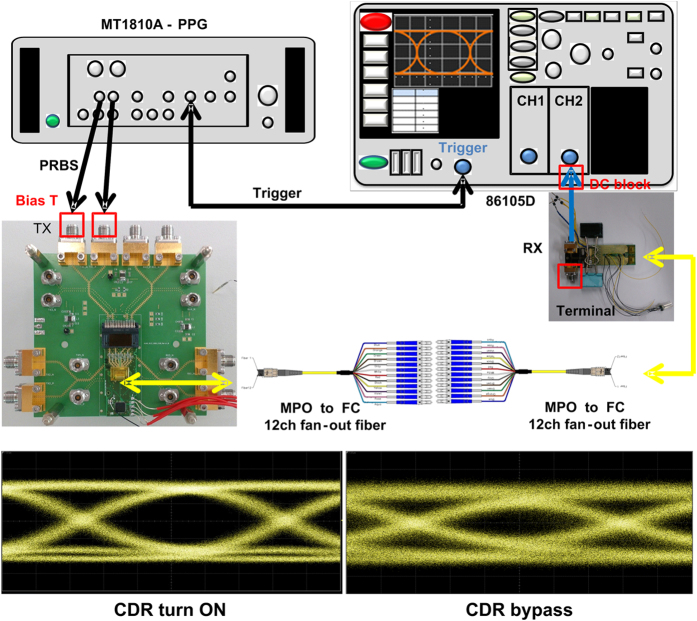
The electrical eye-diagram measurement of the thermoelectrically separated 400-Gbps CDFP receiver.(a) The experimental setup of receiver eye diagram measurement; (b) The received eye diagrams with and without CDR functionality.